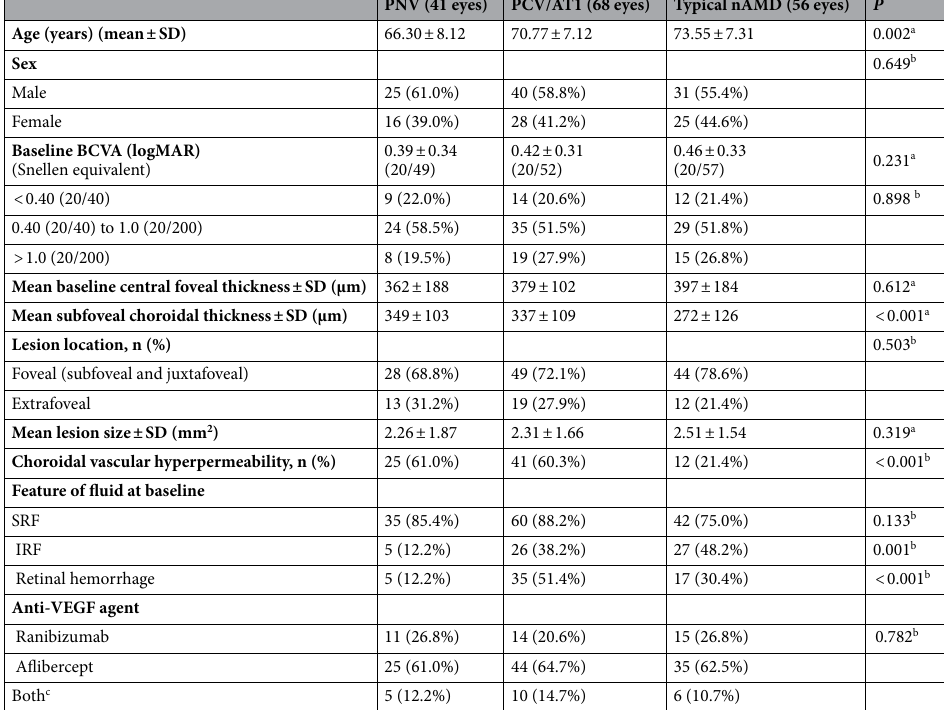
Table 1. Baseline characteristics of patients treated with anti-VEGF for macular neovascularization. a Based on one-way analysis of variance. b Based on chi-square test. c Patients for whom the anti-VEGF treatment was switched during the study period; there was a switch from ranibizumab to aflibercept for 14 eyes (66.7%) and a switch from aflibercept to ranibizumab for the others. BCVA best-corrected visual acuity, IRF intraretinal fluid, logMAR logarithm of the minimum angle of resolution, nAMD neovascular age-related macular degeneration, PCV/AT1 polypoidal choroidal vasculopathy/aneurysmal type 1 neovascularization, PNV pachychoroid neovasculopathy, SD standard deviation, SRF subretinal fluid, VEGF vascular endothelial growth